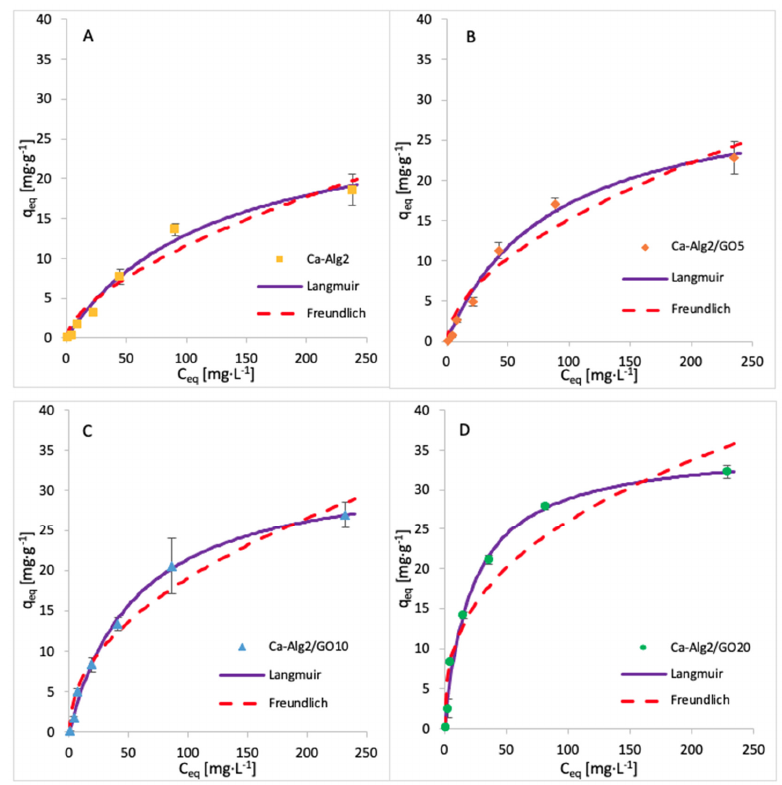
Figure 14. Adsorption isotherms of FMTD using ( A ) Ca-Alg2, ( B ) Ca-Alg2/GO5, ( C ) Ca-Alg2/GO10 and ( D ) Ca-Alg2/GO20 dried beads. Materials 2021 , 14 , x FOR PEER REVIEW Table 9. Langmuir and Freundlich isotherm constants for DFC adsorption onto Ca-Alg2 and Ca-Alg2/GO beads. Langmuir Freundlich Adsorbent